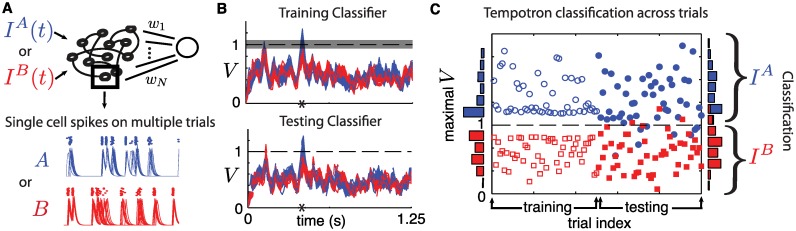
(A) Schematic of a Tempotron with readout weights wi. For one neuron from the chaotic network, we show spike times (dots) of a randomly chosen neuron across several trials for inputs IA or IB, together with the filtered traces for these spike times. (B) Tempotron voltage traces V(t) for a time window of T = 1.25 seconds. Top: traces used for training. Bottom: traces used for testing. Grey shaded area surrounding threshold Vthr shows training margin. Asterisk shows time of maximal output. (C) Classification for all training and testing trials. Markers show the Tempotron’s maximal voltage V in time window T. A correct classification corresponds to blue circles (IA) above threshold and red squares (IB) below. For all panels, the stimuli IA or IB have ρsame = 0.9.